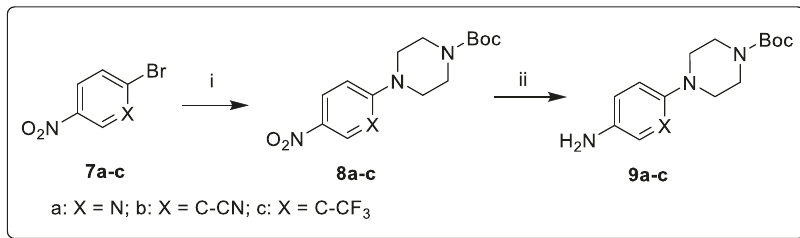
Fig. 3 The synthetic route of 9a – c. (i) 1-Boc-piperazine, K 2 CO 3 , DMF, 120 °C; (ii) H 2 , Pd/C,